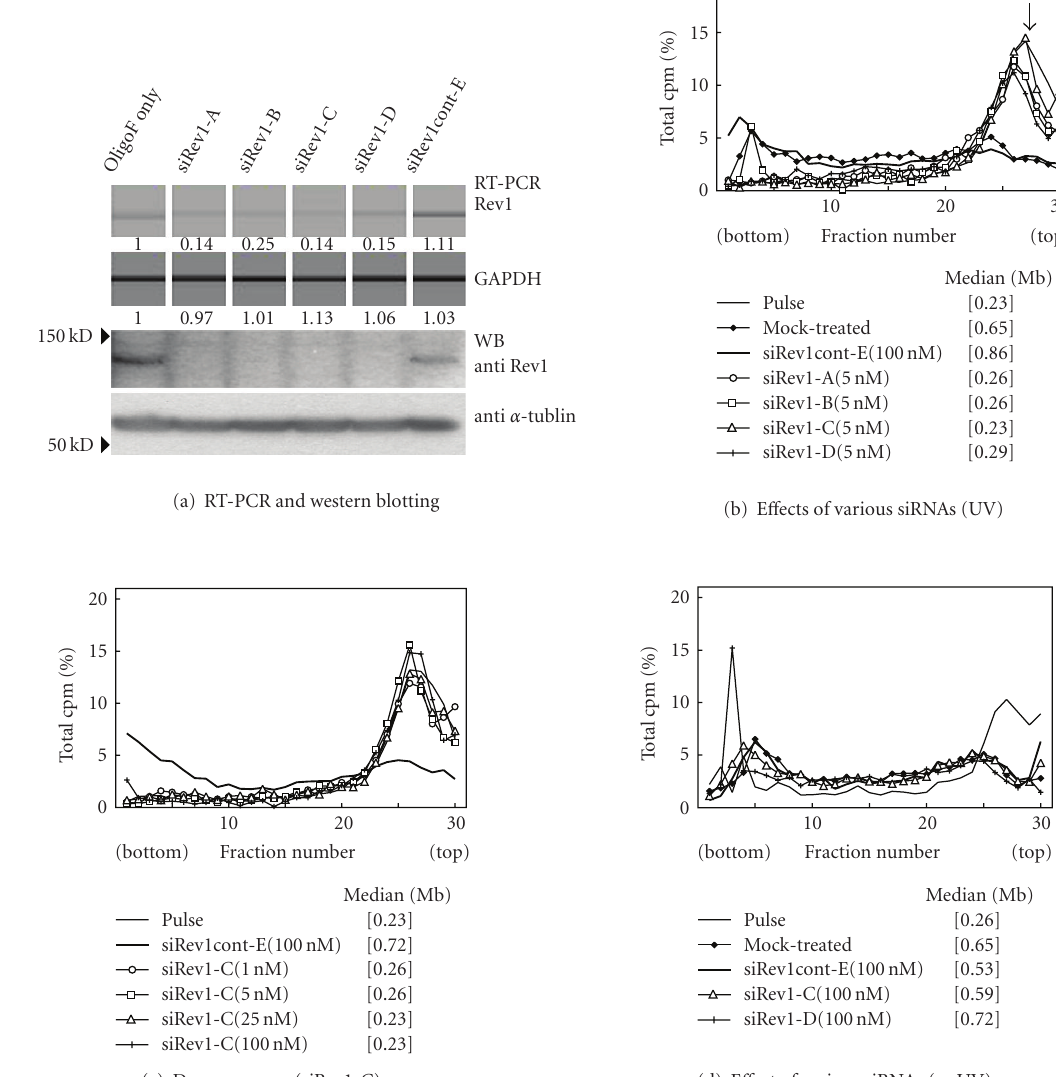
Figure 3: E ffi cient knockdown by Rev1 siRNAs and their e ff ects on UV-induced TLS in HeLa cells (ASDG profiles of replication products). (a) E ffi ciency of knockdown on Rev1 expression (RT-PCR analysis and western blot analysis); (b) E ff ects of various Rev1 siRNAs on UV-TLS; (c) Dose-response of siRev1-C on UV-TLS; (d) E ff ect of various siRNAs (no UV control). Twenty-four hours after Rev1 siRNA transfection, total RNA was isolated and Rev1 RNA was quantified by RT-PCR. Results were shown in MultiNA gel images and the expression